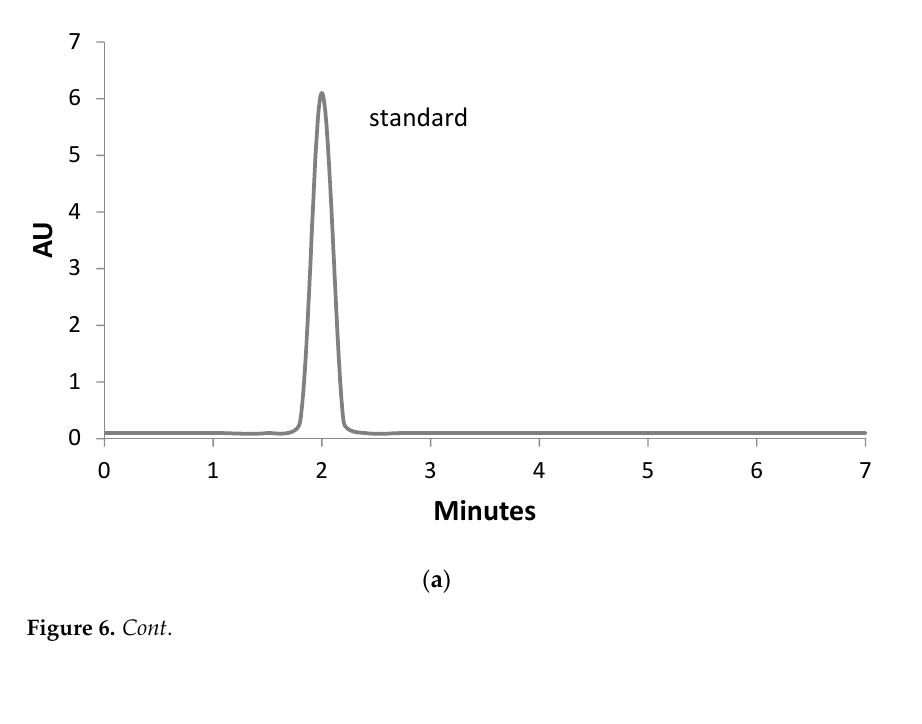
Figure 5. FTIR spectrum of vanillin.